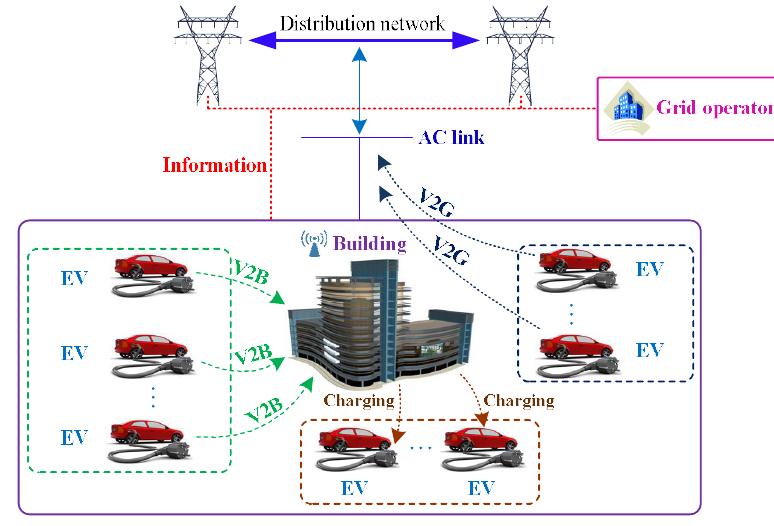
Figure 3. Paradigm of V2B.